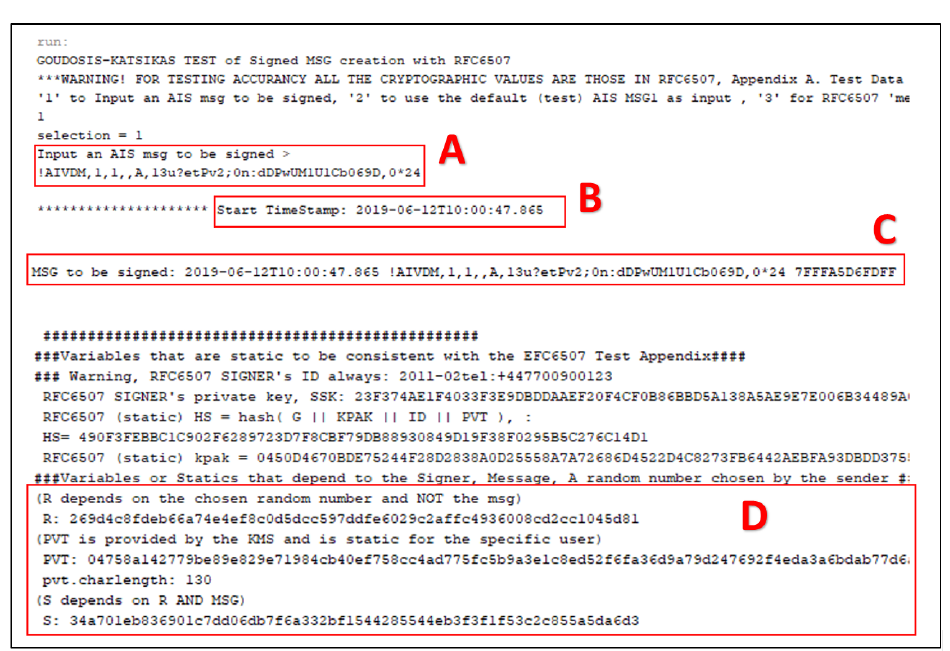
Figure 4. Original ID1 AIS message ( A ); timestamp ( B ); message to be signed ( C ); signature ( D